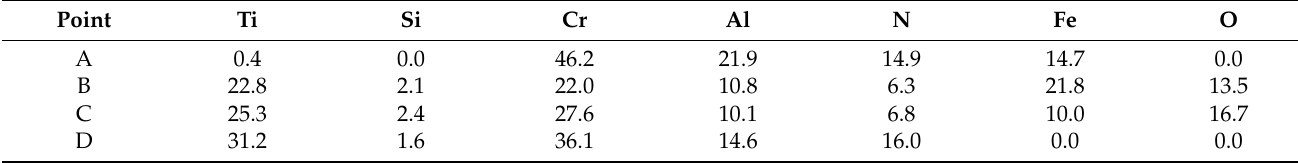
Figure 12. Wear scar morphology and elemental distribution of CrAlN/TiSiN under no − sand conditions: ( a ) Multilayer and ( b ) Nanomultilayer. Table 3. Chemical composition at typical position of wear scar (wt.%).